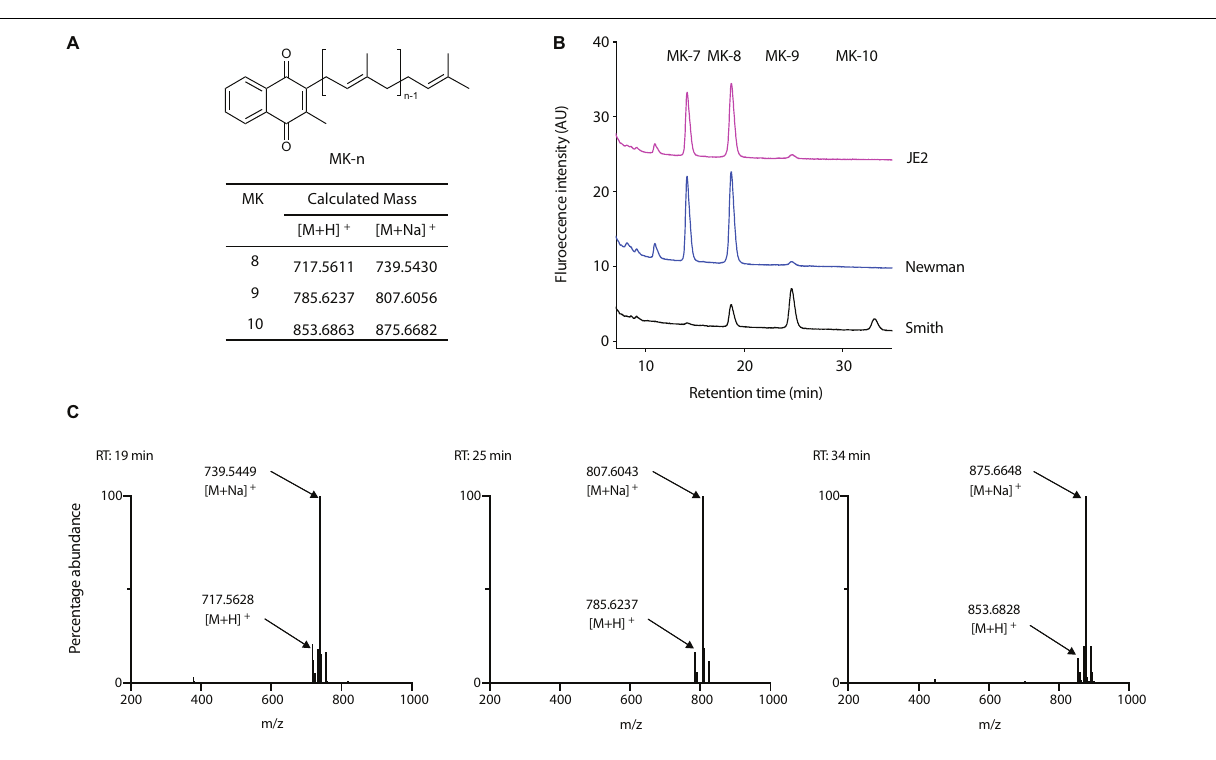
Frontiers in Microbiology |